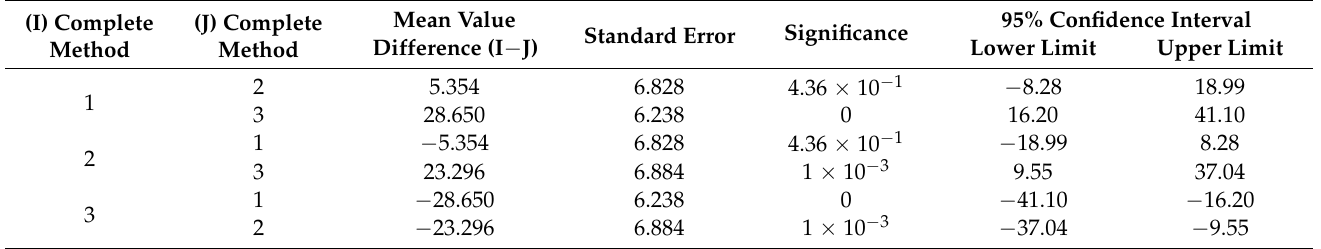
Table 4. Pairwise comparison of academic performance of different SRL